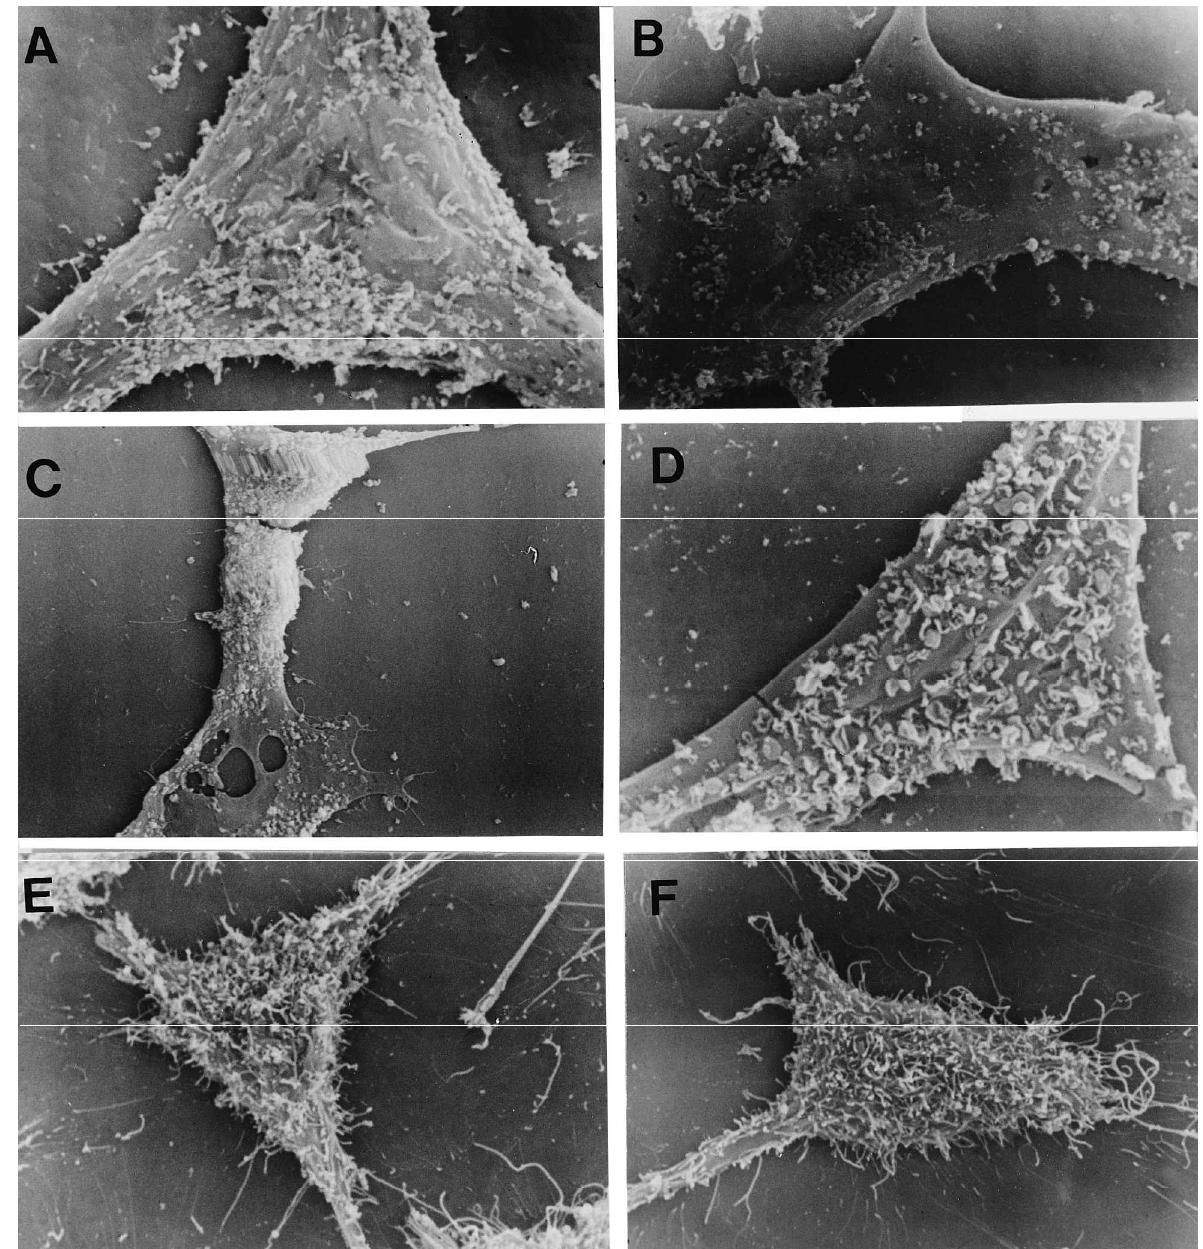
FIG. 3. Scanning electron microscopy of RIN-5AH cells treated with: (A) PBS at a magnification of 3 3300; (B) aminoguanidine at 3 3500; (C) IL-1 a at 3 2000; (D) IL-1 a +aminoguanidine at 3 2500; (E) IL-1 b at 3 2000; (F) IL-1 b +aminoguanidine at 3